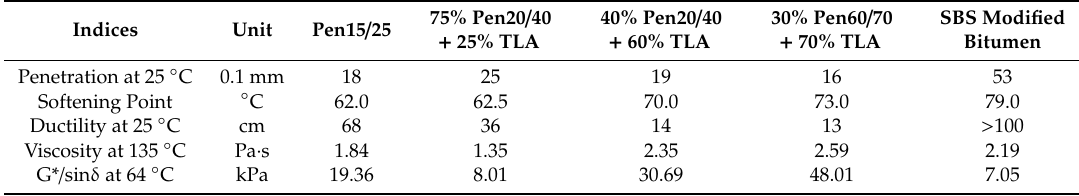
Table 2. Test results of bituminous binders used in the study.